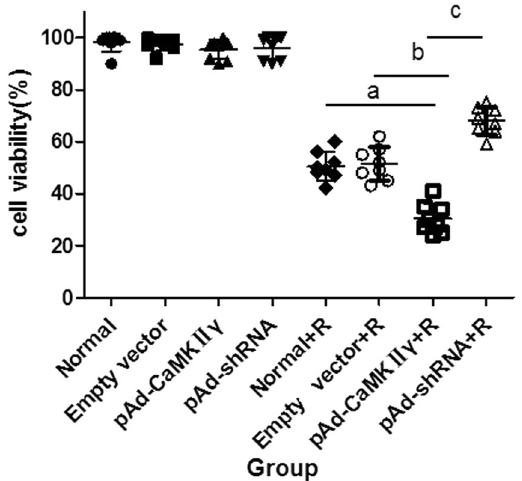
Figure 2. The effects of ropivacaine hydrochloride on the cells in each group. ( x ± s, %, n = 8). a P < 0.05 vs. Normal + R group, b P < 0.05 vs. Empty vector group, c P < 0.05 vs. pAd-CaMK II γ